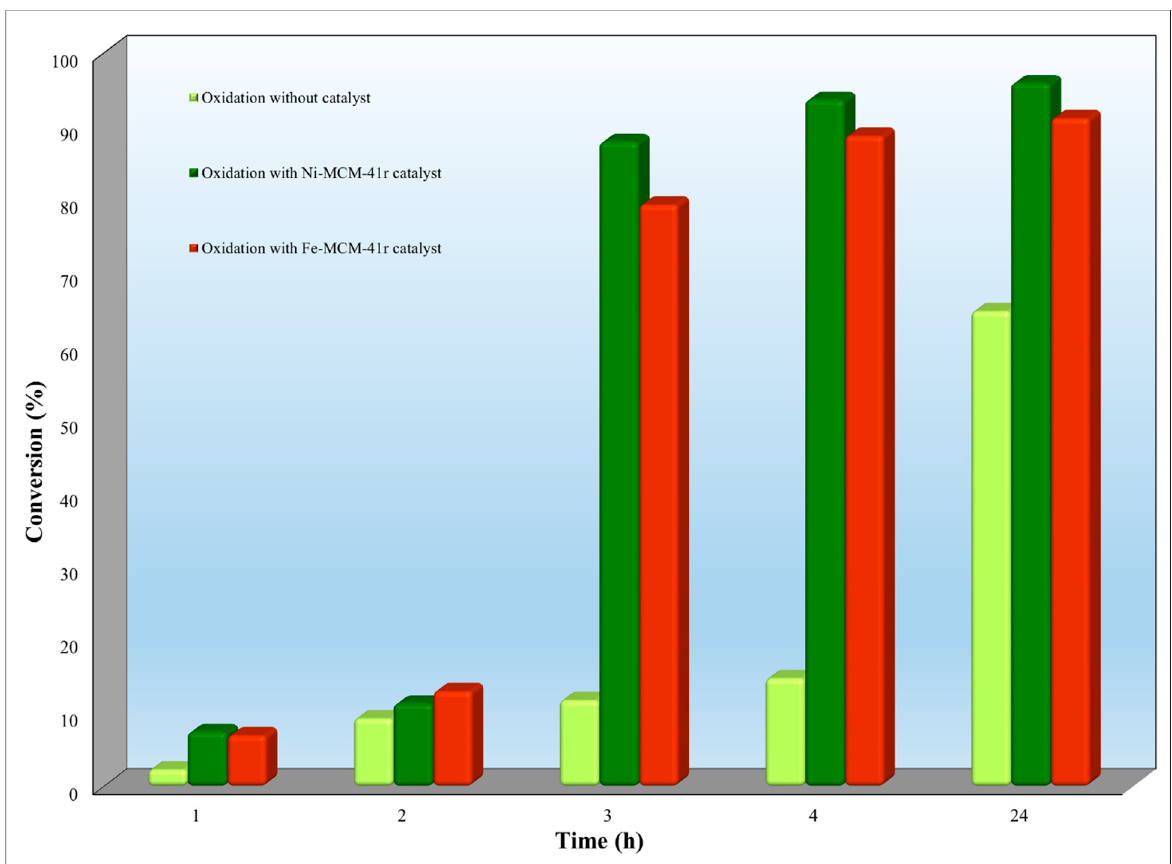
Figure 10. Ni-MCM-41 r and Fe-MCM-41 r catalytic activity on rhodamine oxidation (5 mg/L dye, 50 mg catalyst, 5 mL H 2 O 2 , 9.2 mL acetonitrile as solvent).